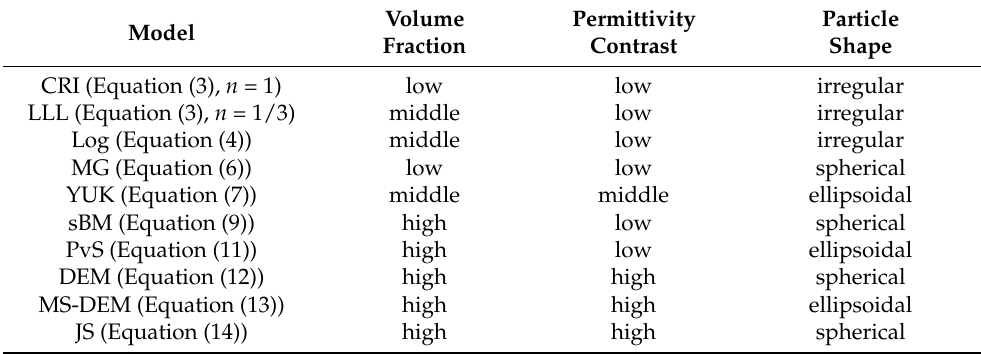
Table 1. Scope of applicability of the ten effective-medium